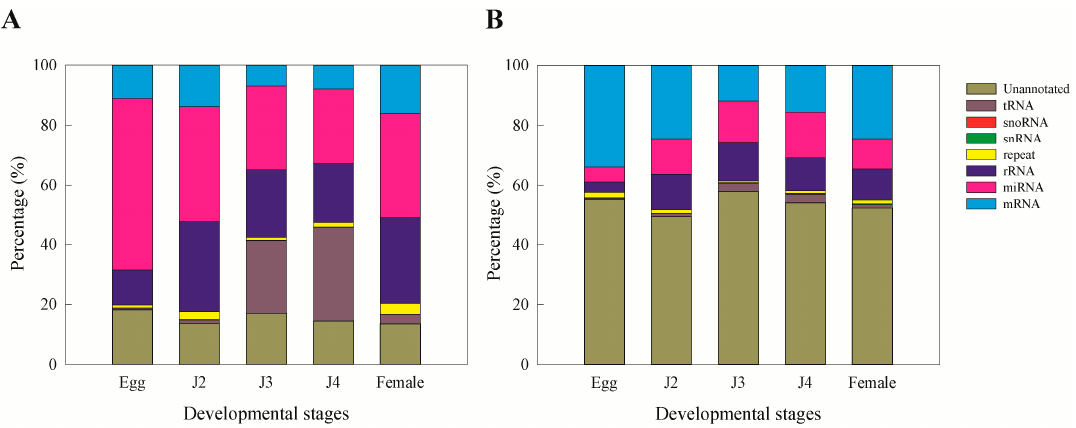
Figure 3. Annotation of small RNAs of M. incognita . ( A ) Clean reads; ( B ) unique reads.